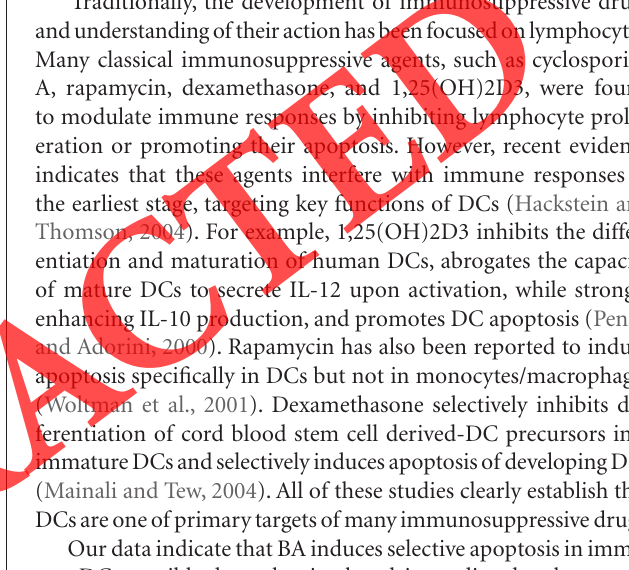
Figure 5 | The impact of BA on mitochondrial transmembrane potential in immature and mature DC. Immature and mature DCs were treated with BA (0–50 μM) for 6 h, stained with JC-1 dye probe, and analyzed by flow cytometry. Numbers in lower right quadrant indicate the percentage of cells that emit only green fluorescence which is attributed to depolarized mitochondrial membrane. Representative of three individual experiments with similar results